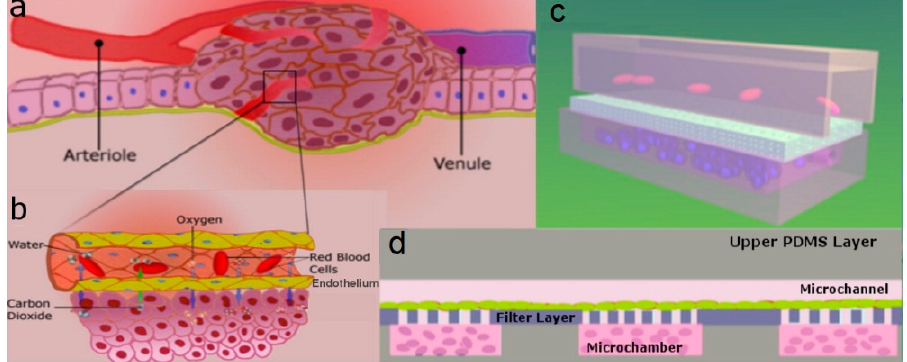
Figure 5. Schematic representation of: ( a ) tumor microenvironment; and ( b ) detailed view of blood